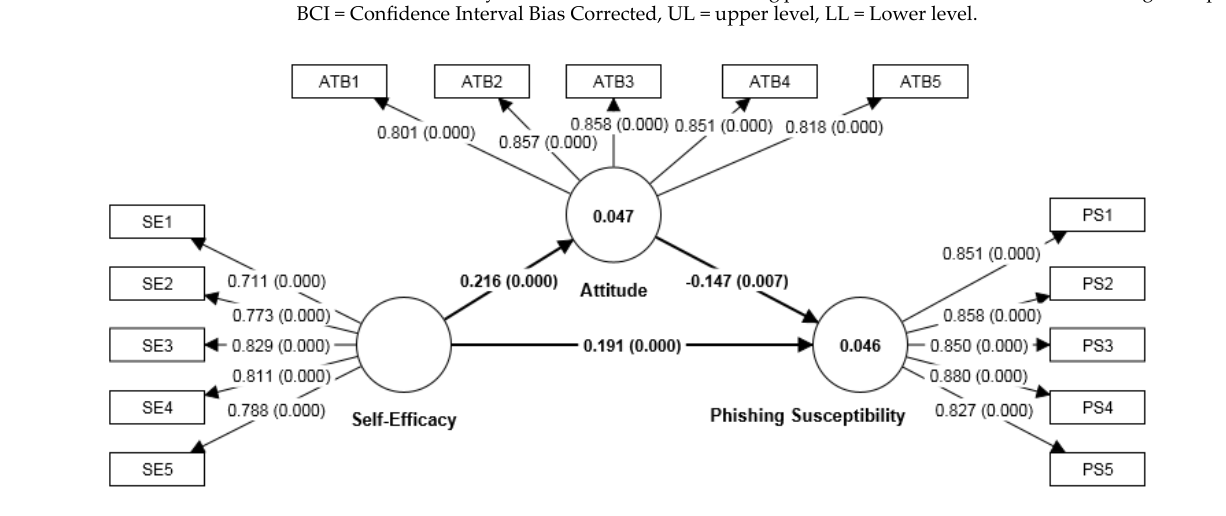
Figure 2. Structure model. Note: Inner model (paths) indicates the coefficients and p ‑values in parenthesis. Outer model (paths) indicates the item loadings and p ‑values in parentheses. Constructs ATB and PS show the R 2 value.